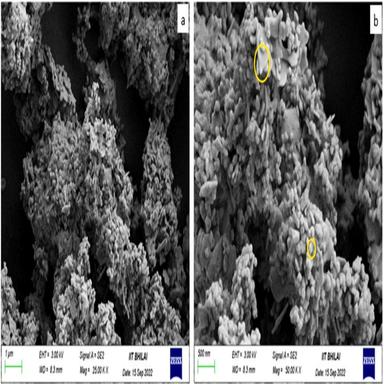
FESEM images of (a) MTZ –ZnMoO4 nanocomposite; (b) enlarged view of MTZ – ZnMoO4 nanocomposite.